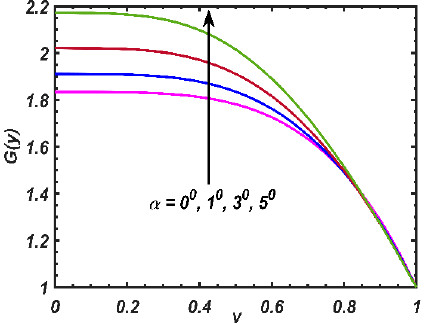
Figure 5. Figure 5. Variation of G(y) in diverging channel for α = 0 0 , 1 0 ,3 0 , 5 0 and Ec = 0.5, Re = 100, Figure Pr = 5, H = 0. Figure